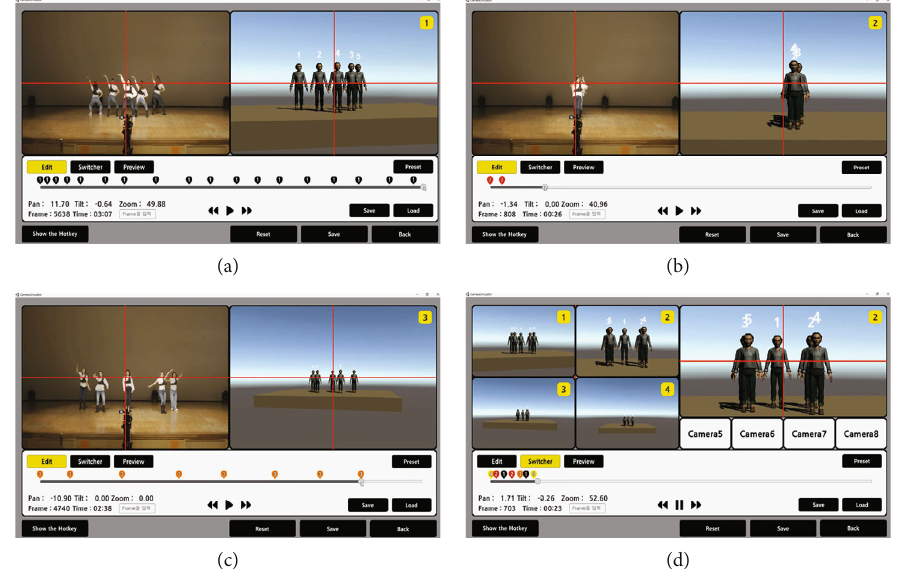
Figure 7: (a) – (c) A scene producing the pan, tilt, and magni fi cation con fi guration of cameras No. 1 – 3 using the simulator. (d) A view of switching production, as shown in four cameras at the upper left